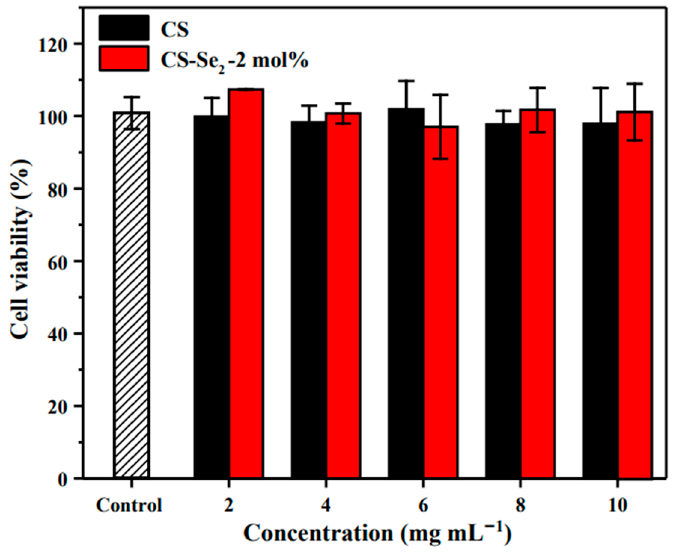
Figure 6. Cell viability measured by CCK-8 assays for chitosan and Se-containing chitosan hydrogels extract of different concentration after 24 h of incubation. Data are shown as mean ± standard deviation ( n = 3).